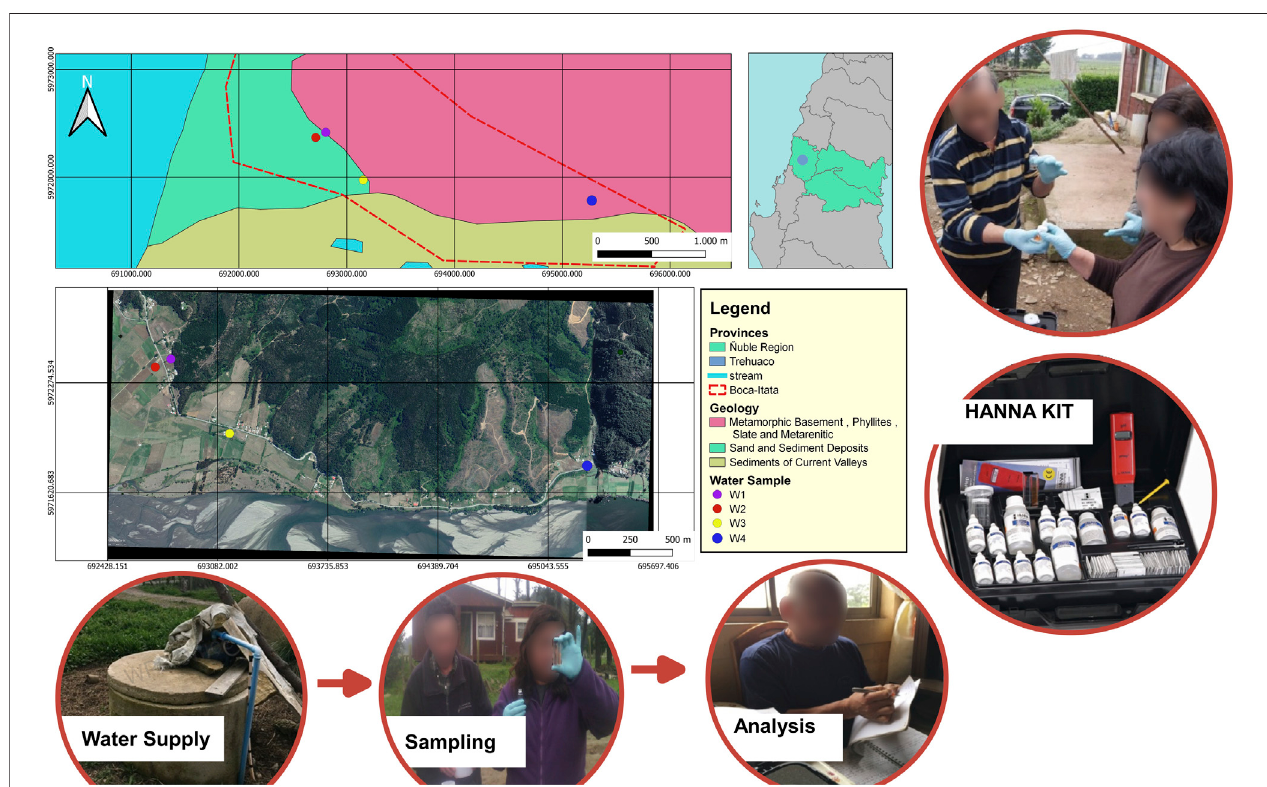
FIGURE 1 | Location of groundwater sampling sites (w) in Boca Itata, Trehuaco, Ñuble region in Central Chile.